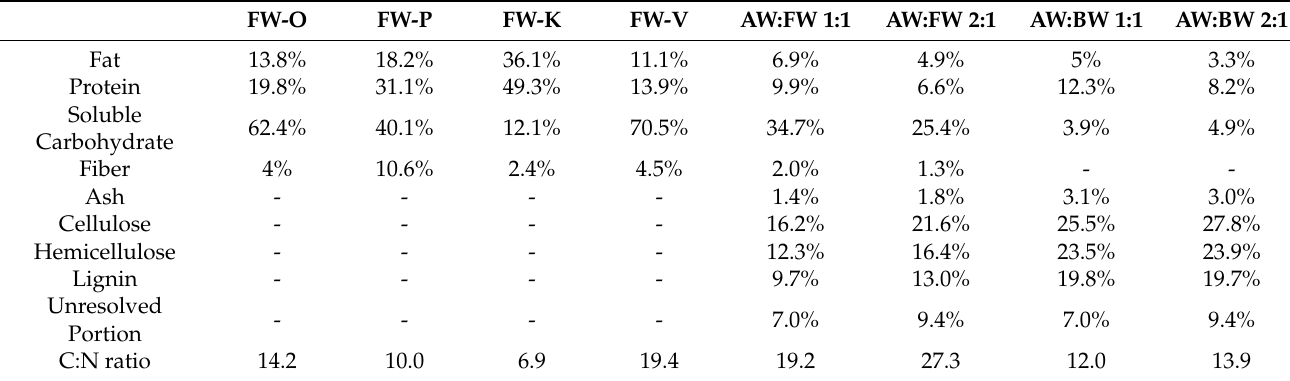
Table 2. Compositions of food waste